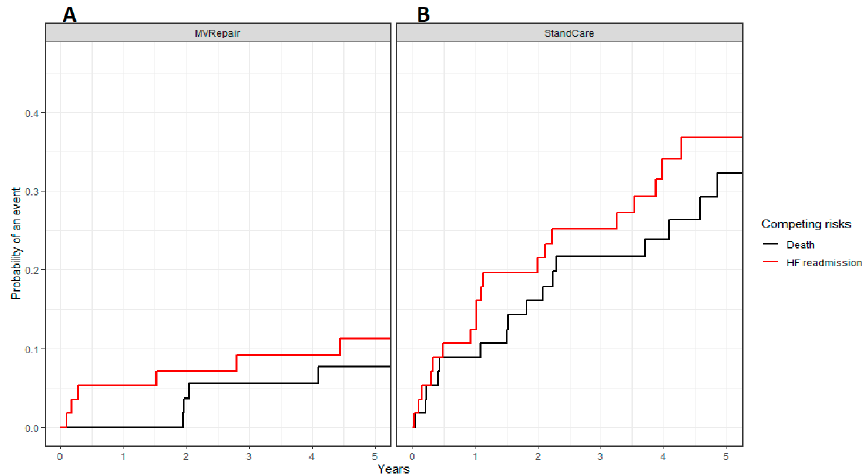
Figure 5. Estimated cumulative incidence curves for all-cause mortality (black) and HFpEF readmissions (red) as competing events for MVRepair ( A ) and StanCare ( B ) groups in population with propensity score matching.